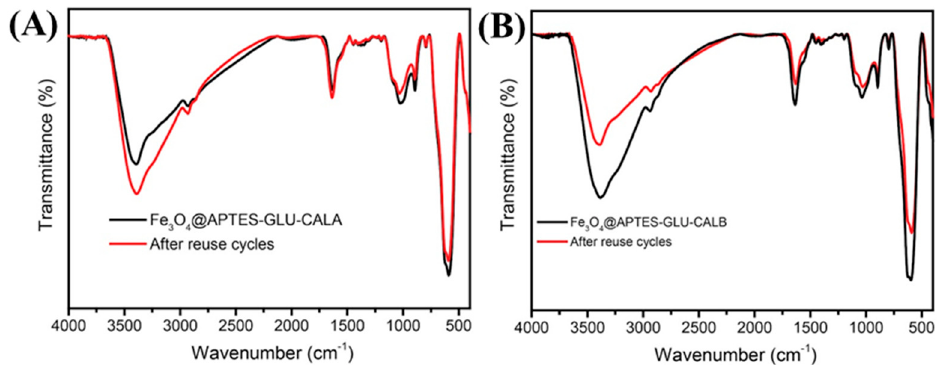
Figure 7. FT-IR spectra for CALA-MNP ( A ) and CALA-MNP ( B ) before and after 10 consecutive reuses. Further details are given in Section 3.